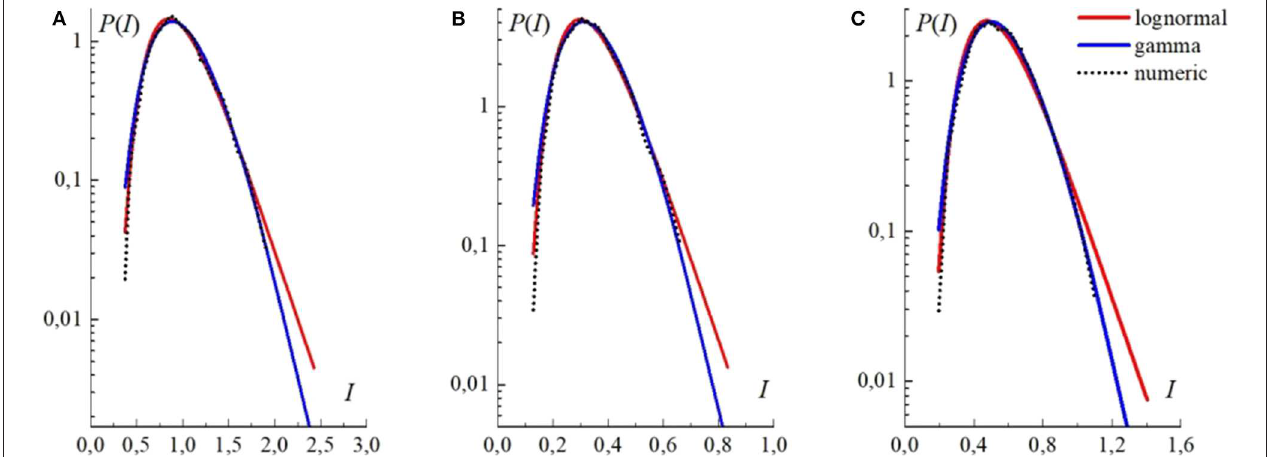
0) of the Gaussian beam, (B) at the peak point ( r = 0.47 a ) of the synthesized beam ( N a = 0.1. Dotted curves correspond to the lognormal distribution [30], and the =